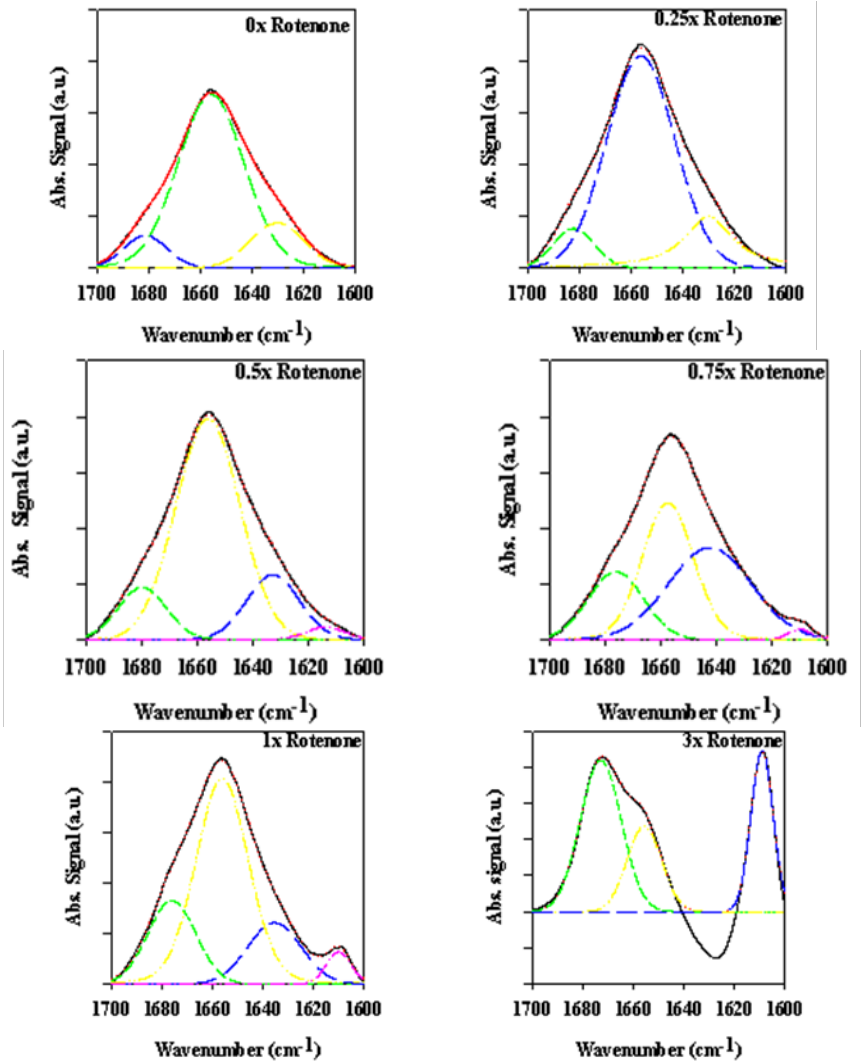
Figure 6. ATR-FTIR spectra of bovine serum albumin (BSA) in the presence of various rotenone equivalents after a 30-min incubation period.